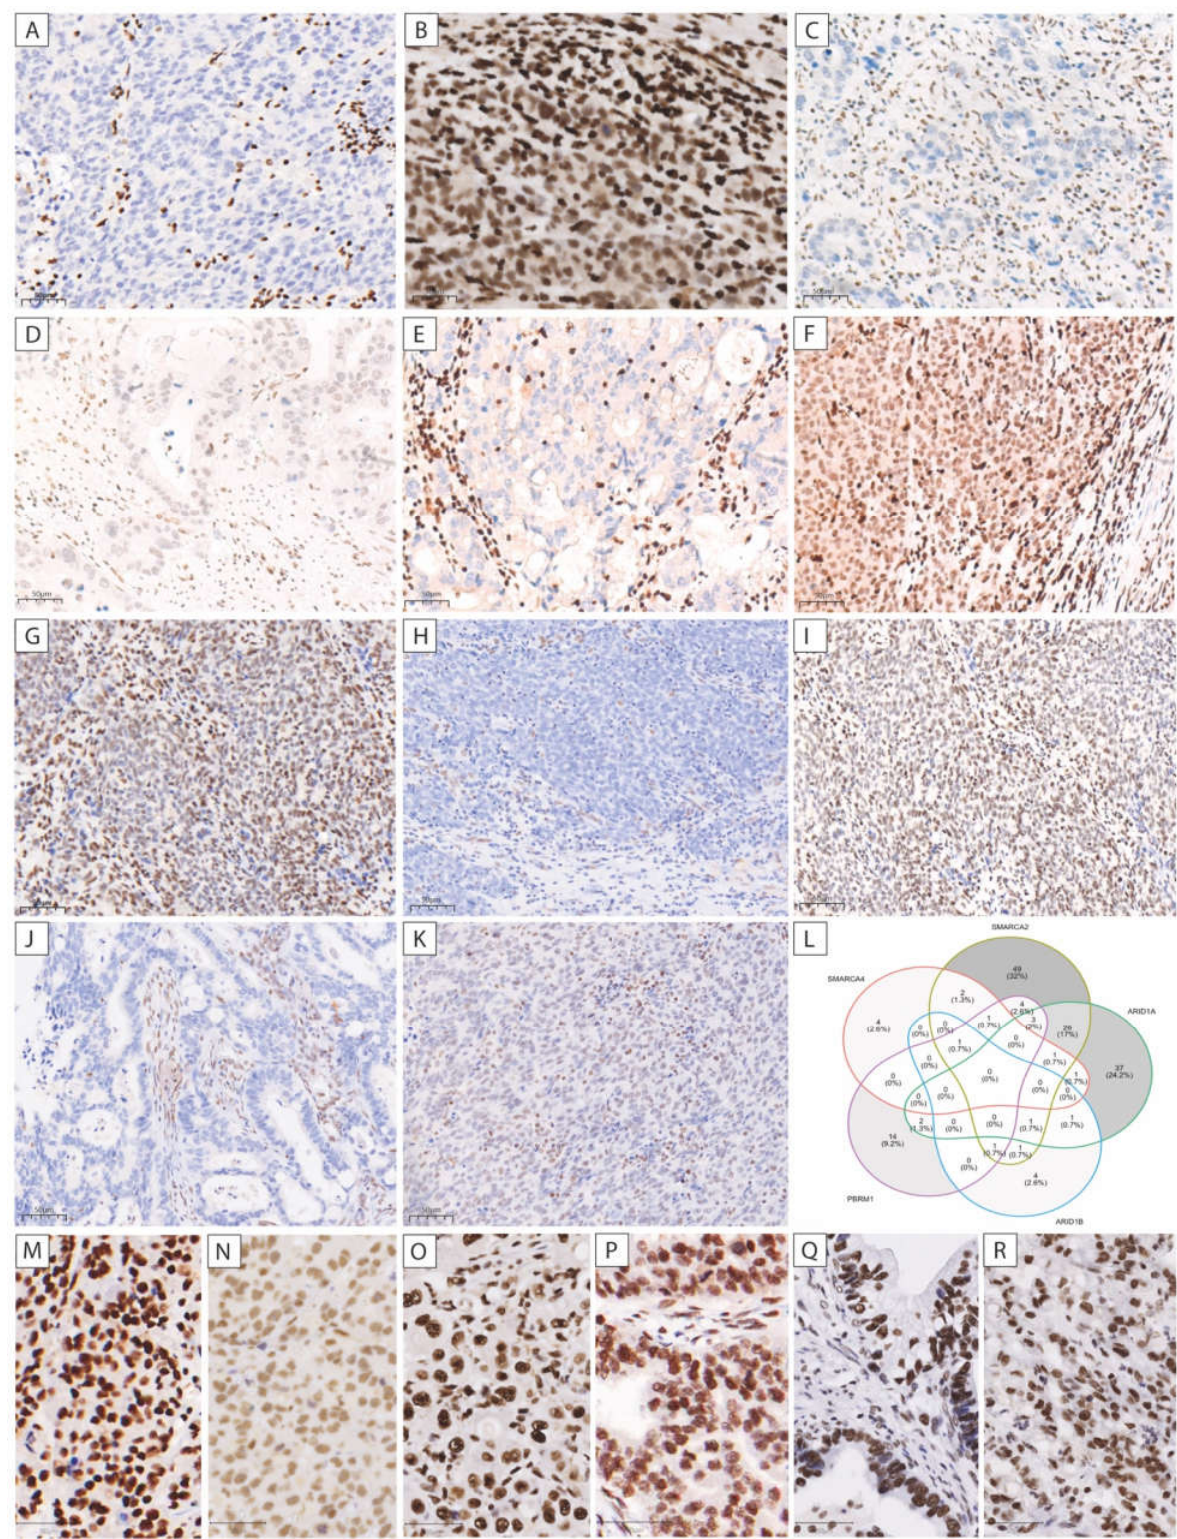
Figure 2. Representative images of immunohistochemical expression patterns of the proteins of the SWI/SNF complex. Complete loss of SMARCA4 ( A ), SMARCA2 ( C ), ARID1A ( E ), ARID1B ( H ), PBRM1 ( J ), and reduced expression of SMARCA4 ( B ), SMARCA2 ( D ), ARID1A ( F ), SMARCB1 ( G ), ARID1B ( I ), and PBRM1 ( K ) are shown. Venn-diagram of patients with loss or reduced expression of one of the proteins of the SWI/SNF complex ( L ). Retained expression patterns for SMARCA4 ( M ), SMARCA2 ( N ), ARID1A ( O ), SMARCB1 ( P ), ARID1B ( Q ), and PBRM1 ( R ) are presented. Scale bar = 50 µ